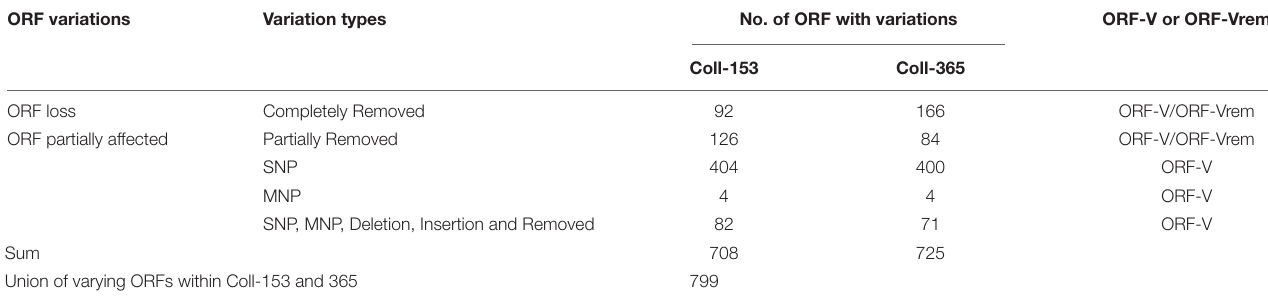
TABLE 3 | Open reading frame variation statistics of strains Coll-153 and Coll-365 detected and calculated based on the method shown in Figure 1 . ORF variations